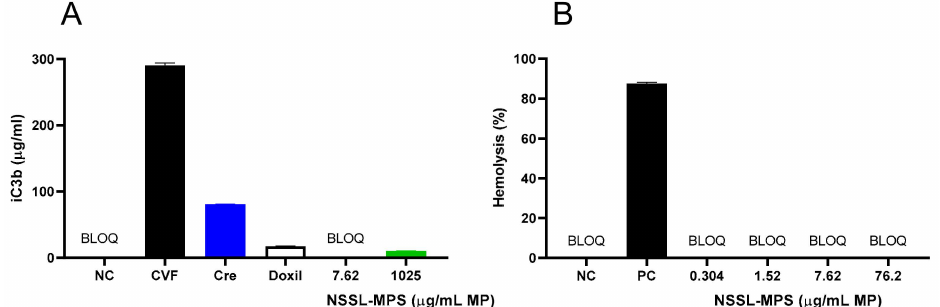
Figure 1. Evaluation of in vitro activation of the complement system and hemolytic properties of PEGylated liposomal methylprednisolone-succinate NSSL-MPS. ( A ) Di ff erent concentrations of NSSL-MPS were incubated in human plasma for 30 min and the increase in iC3b was measured and compared to iC3b activation by Cobra Venom Factor (CVF) ( B ) . Di ff erent concentrations of NSSL-MPS were incubated in whole blood and the free hemoglobin released by damaged erythrocytes was quantified. BLOQ, below limit of quantitation; Cre, Cremophor-EL; CVF, Cobra Venom Factor; NC, Negative Control; PC, Positive Control (Triton-X-100). BLOQ is < 0.13 µ g /